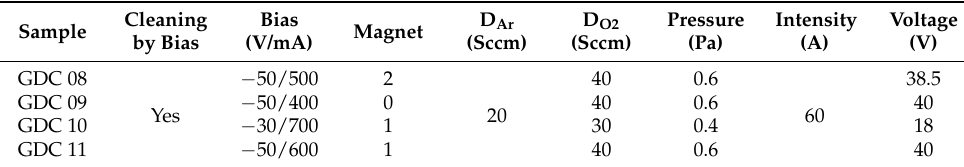
Table 1. Main deposition conditions of the study.